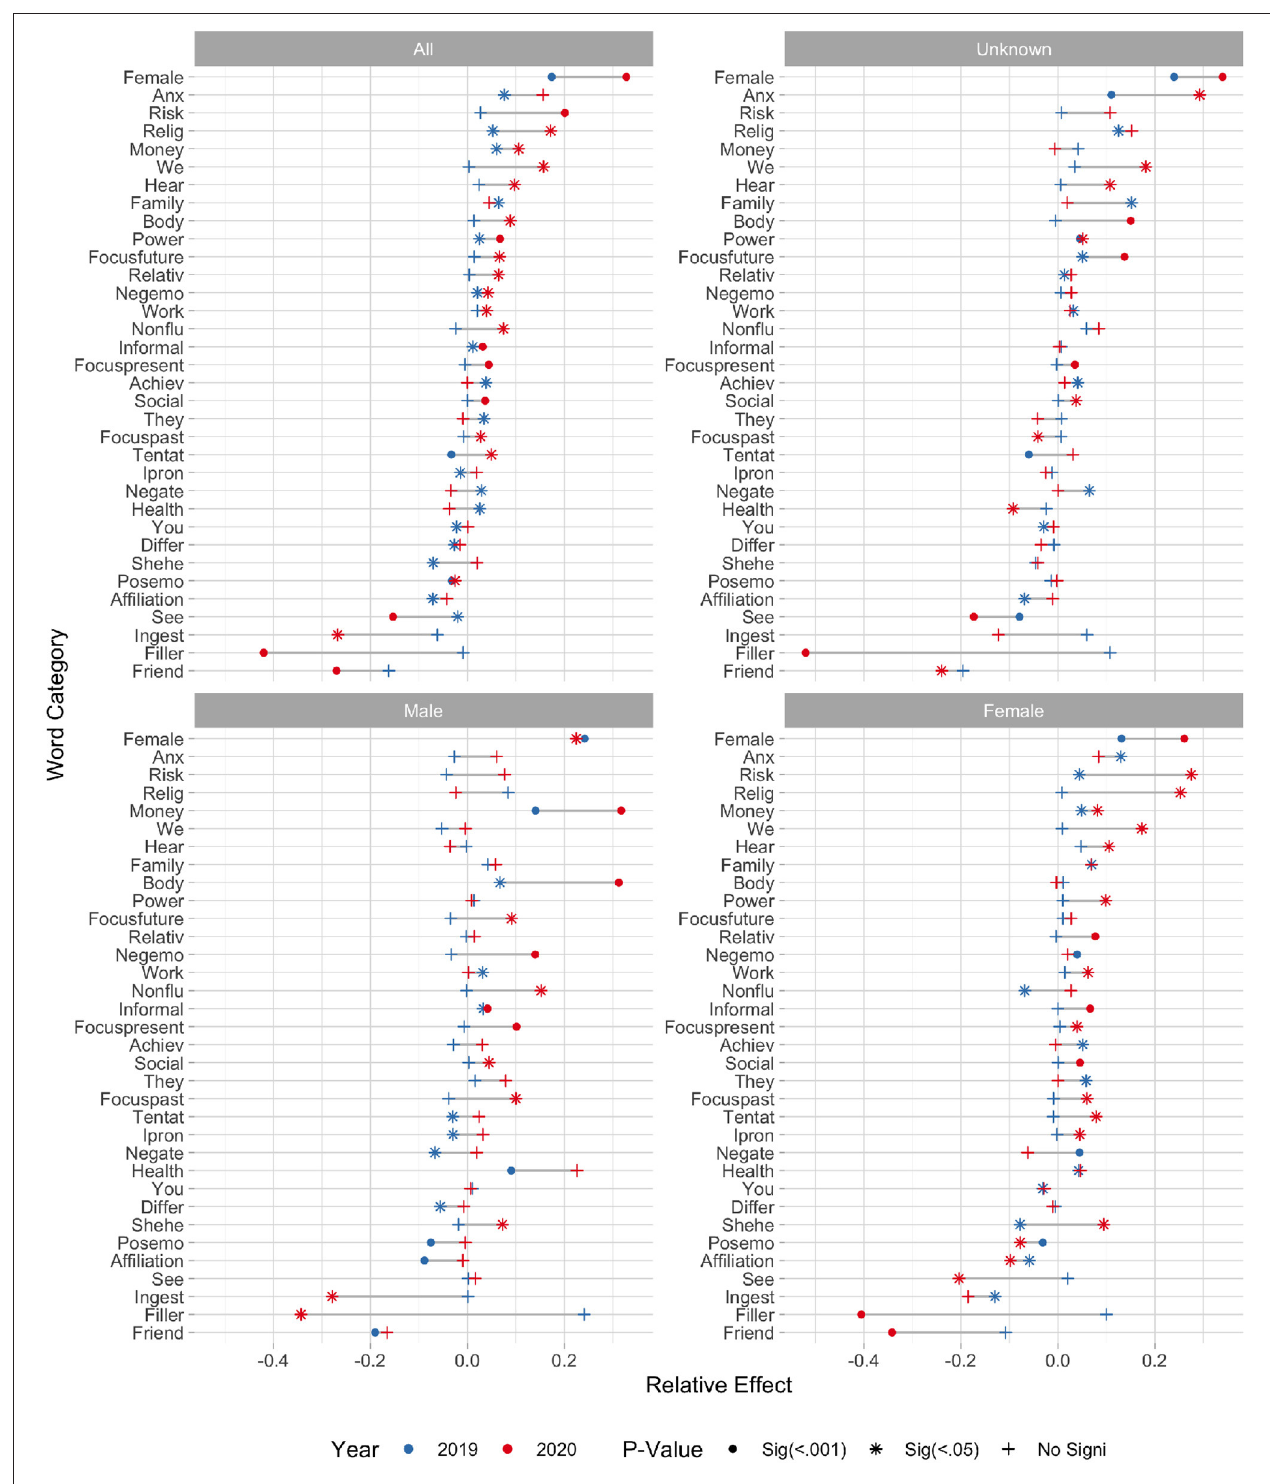
FIGURE 6 | Relative effect of interaction with NEDA content upon users’ use of LIWC categories in 2019 and 2020 campaigns. The p -values are encoded in marker: solid at p < 0.5 and cross for non-significant at 0.05.